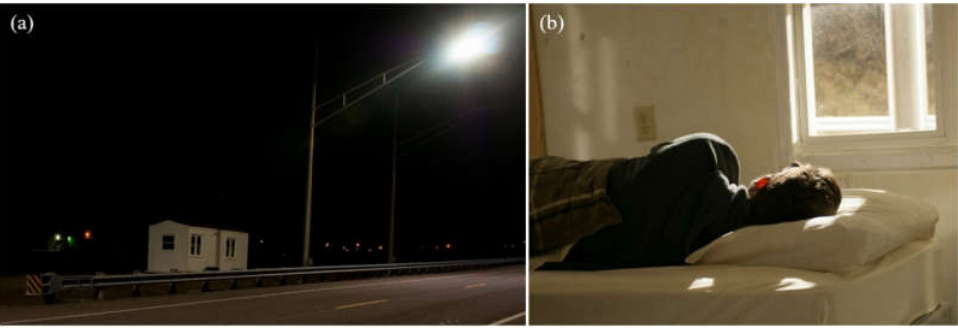
Figure 15. ( a ) Location of the simulated bedroom inside a trailer. ( b ) Participant experiencing the light trespass in the simulated